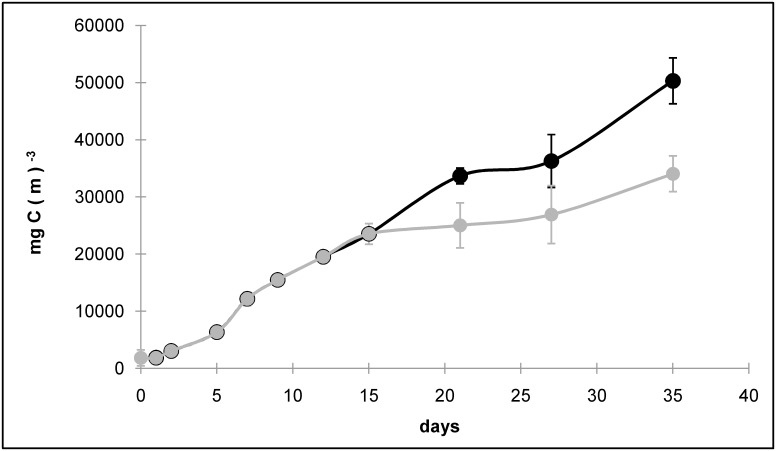
Growth curve of O. cf. ovata observed in the cultures.Black spots represent the POC biomass originally detected by CHN analyzer, while the grey ones are the values corrected through regression.